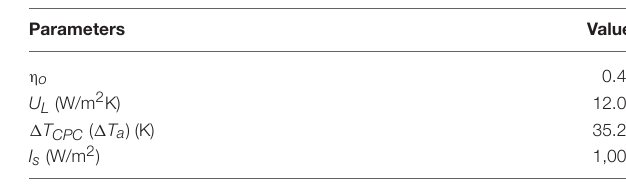
TABLE 1 | The parameters and their values used for the analysis.